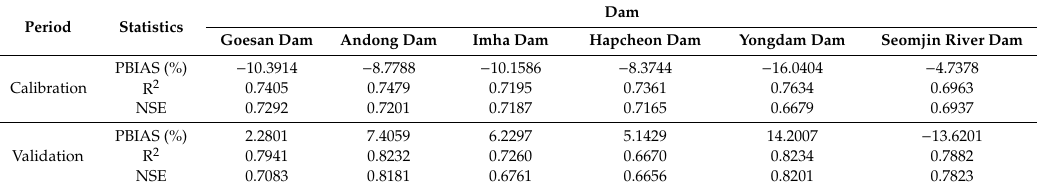
Table 5. Result of the HSPF model calibration and